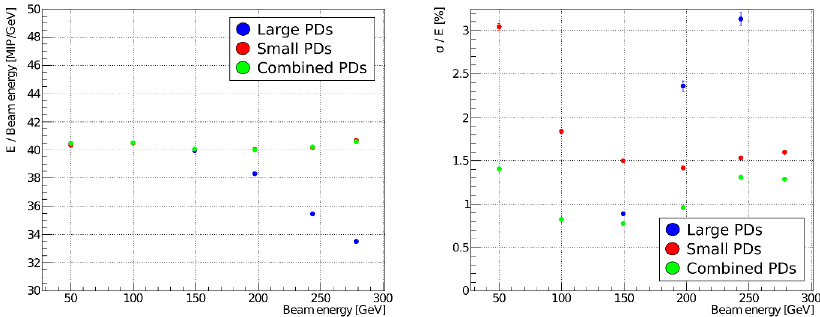
Figure 2. Fraction of the energy deposit in the calorimeter (left) and energy resolution (right) for electrons at di ff erent